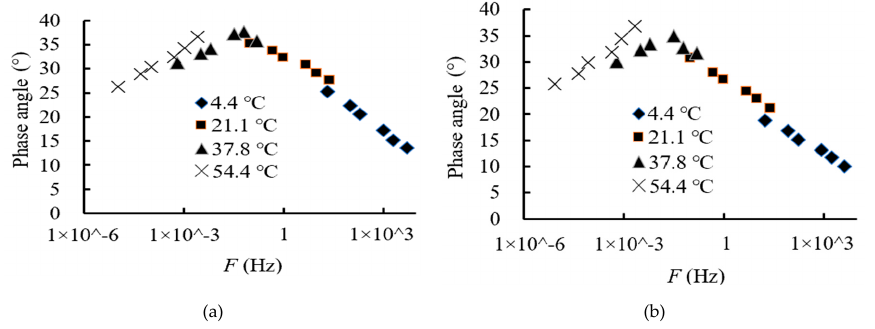
Figure 12. Phase angle master curves: ( a ) BAM, ( b ) HAM.